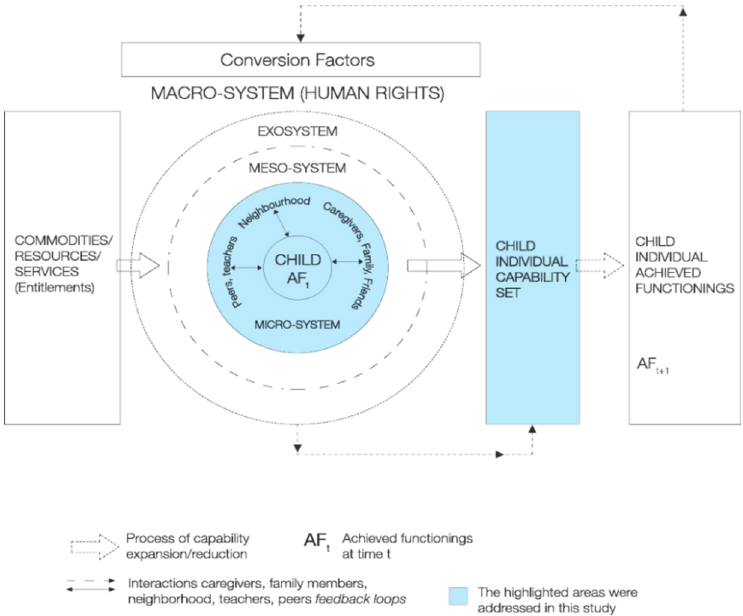
Figure 1. Constitutive elements of capabilities framework for child growth (Yousefzadeh et al., [7]). Reprinted by permission from Springer Nature Customer Service Centre GmbH: Springer Nature, Child Indicators Research, (A Capability Approach to Child Growth, Yousefzadeh, S.; Biggeri, M.; Arciprete, C.; Haisma, H.), Copyright (2018).